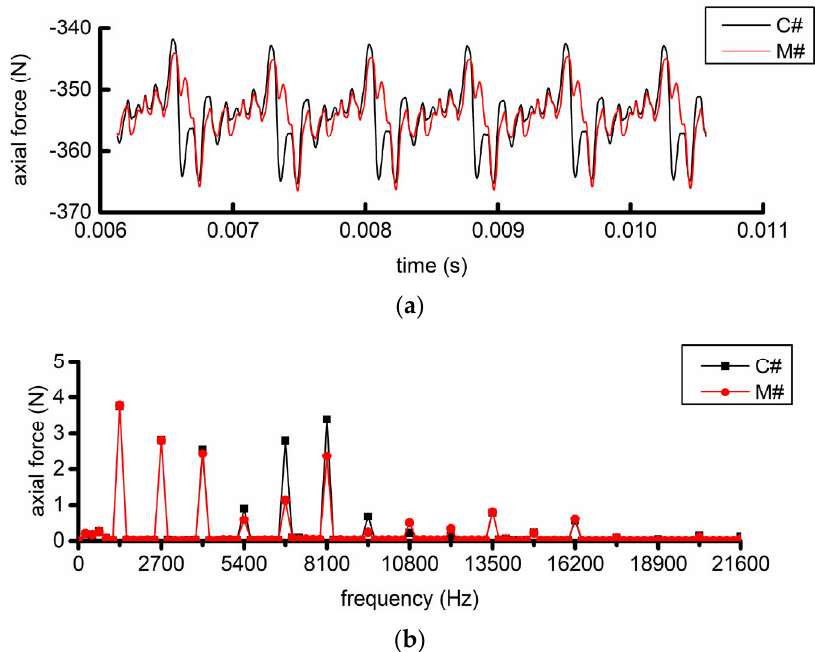
Figure 15. Axial force of R1 rotor blade. ( a ) Time domain ( b ) Frequency domain. Table 1. The relationship between main frequencies of R1 rotor blade force and number of blades.